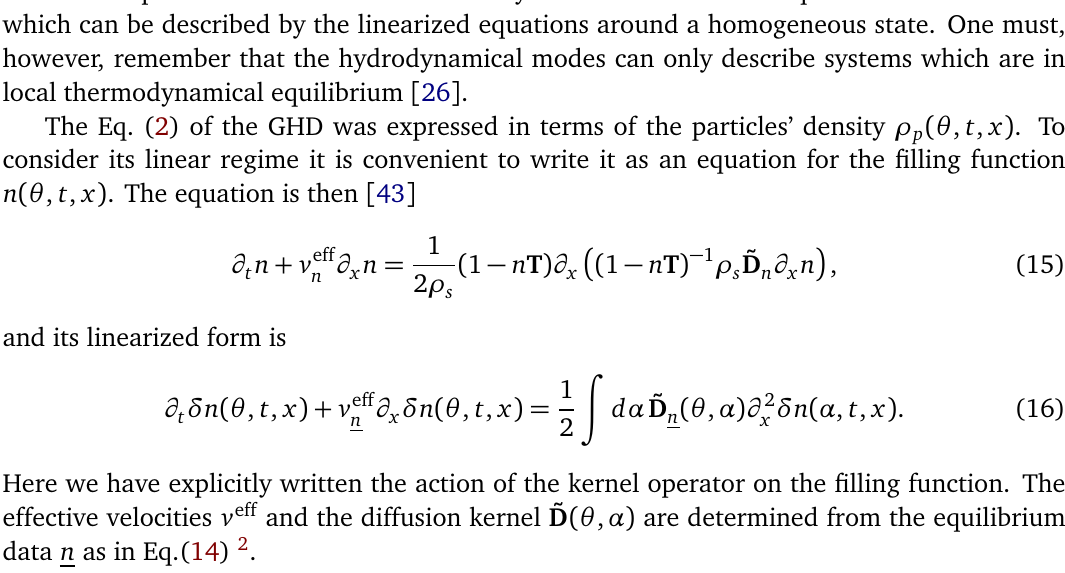
Figure 1: The particle density ρ T = 1 and with c =